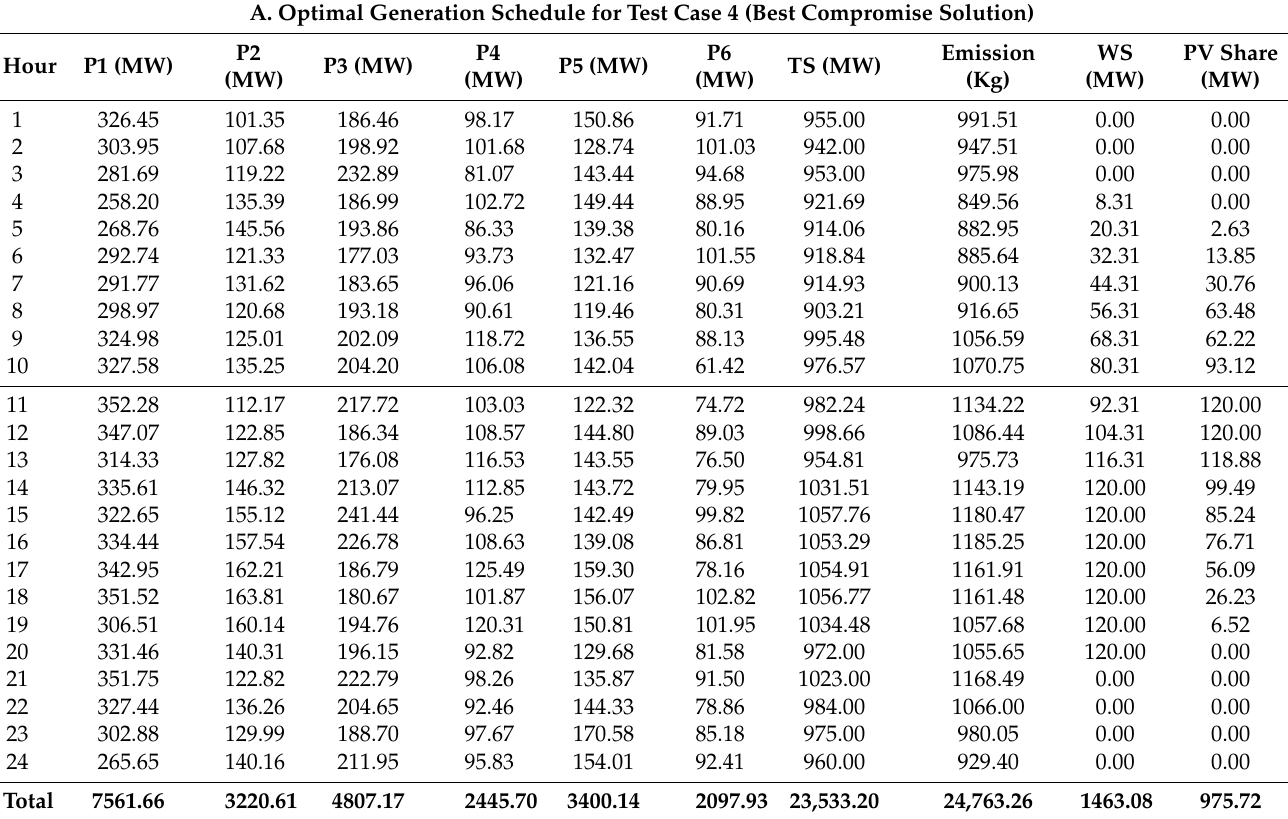
Table 7. Optimal generation schedule, cost, selling price and profit for Test Case 4 (Best Compromise Solution). A. Optimal Generation Schedule for Test Case 4 (Best Compromise